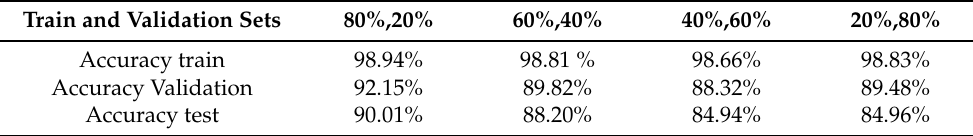
Table 10. The experimental results of cross-validation for 7 electrodes with DA. Train and Validation